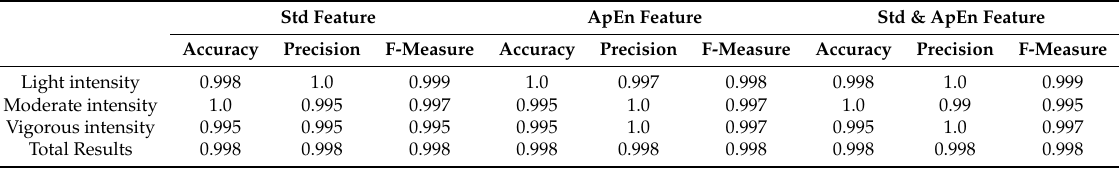
Table 10. Activity level recognition for using the novel designed